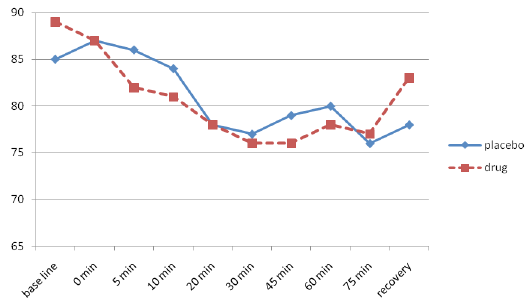
Figure 1. The trend of heartbeat changes (number/minute) in both groups